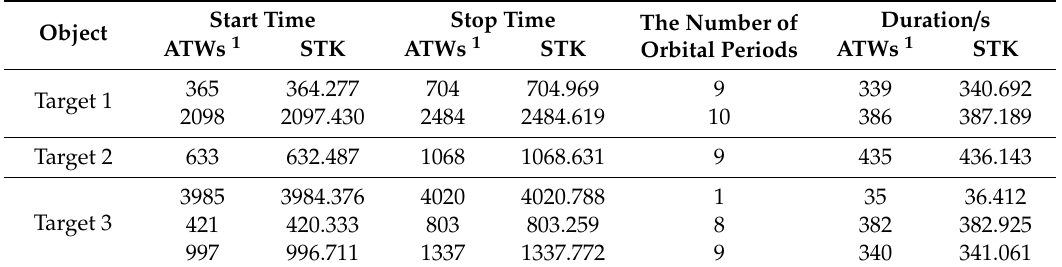
Table 3. Satellite parameters.